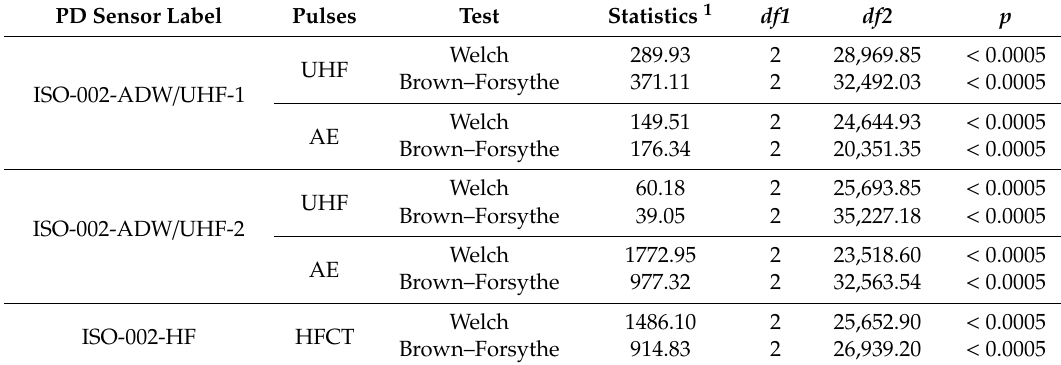
Table 6. Results of robust tests of equality of means.